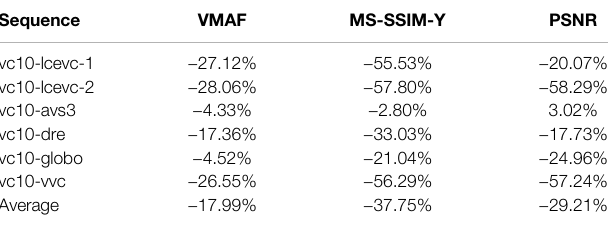
TABLE 10 | BD-rate savings for LCEVC-enhanced x265 over x265 (HLG).